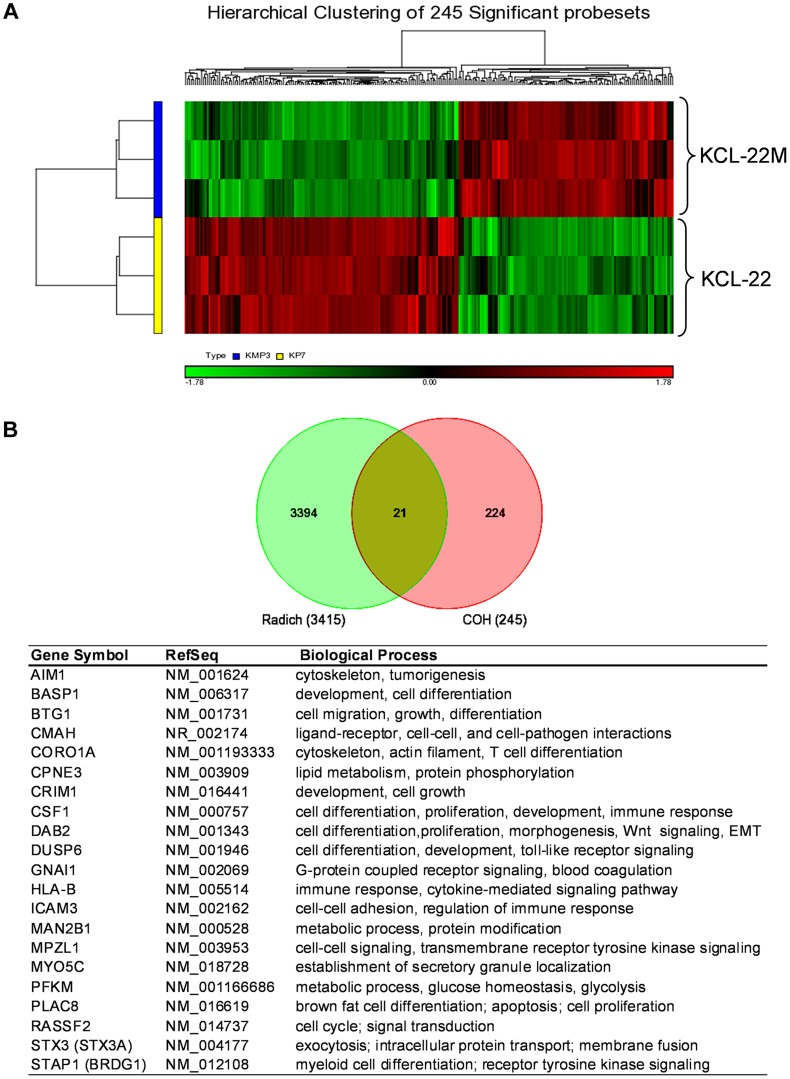
Microarray gene expression analysis of KCL-22 vs KCL-22M cells.(A) Hierarchical clustering of KCL-22M and KCL-22 samples based on the 245 significant probe sets. Clearly, KCL-22M and KCL-22 formed two separate clusters. (B) Venn diagram analysis of 245 significant probe sets of this study versus the published 3415 CML “phase reporter” gene sets from Radich J.P et al. (PNAS 2006, 103: 2794–2799). Details of 21 overlapping genes were listed.